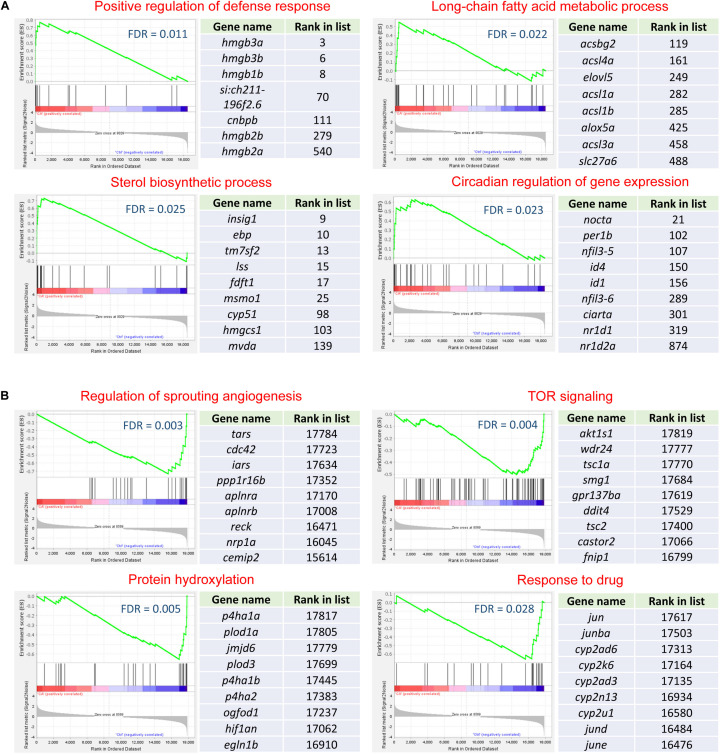
Representative gene sets and their leading-edge genes. (A) Up-regulated gene sets for the brain. (B) Down-regulated gene sets for the heart. For each gene set, the enrichment plot, the leading-edge genes and their rank in the total gene list are shown.